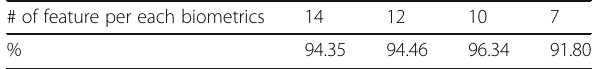
Table 9 Feature-level fusion with DT Table 10 Feature-level fusion with PNN